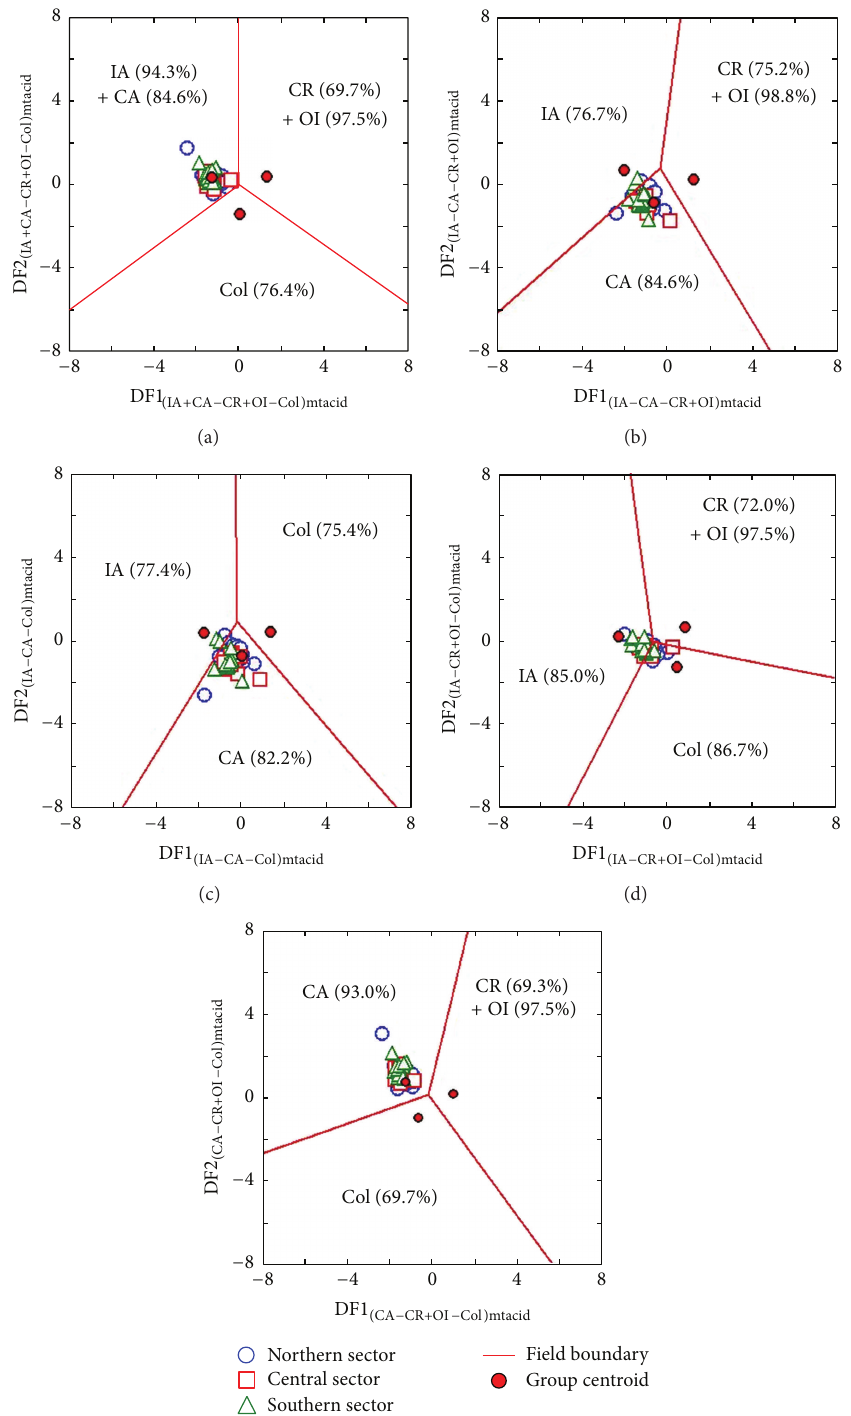
Figure 7: Discriminant-function multidimensional diagrams based on ln-transformed ratios of immobile major and trace elements for tectonic discrimination of acid Sierra de las Cruces magmas. The symbols are explained as inset in (a); more details are in Figure 6. The subscript “mtacid” in axis names refers to major (m) and trace (t) element ratios for acid (acid)